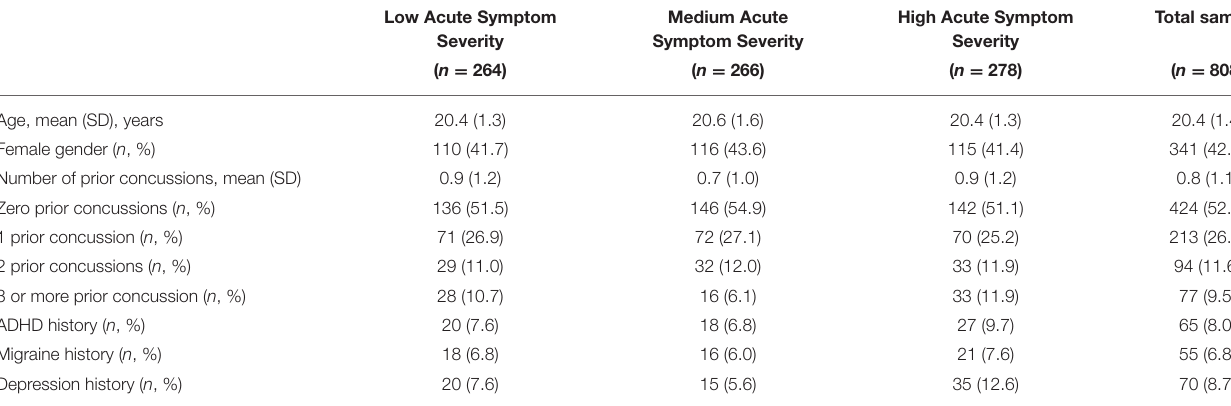
TABLE 1 | Summary of demographic and health history information between acute symptom